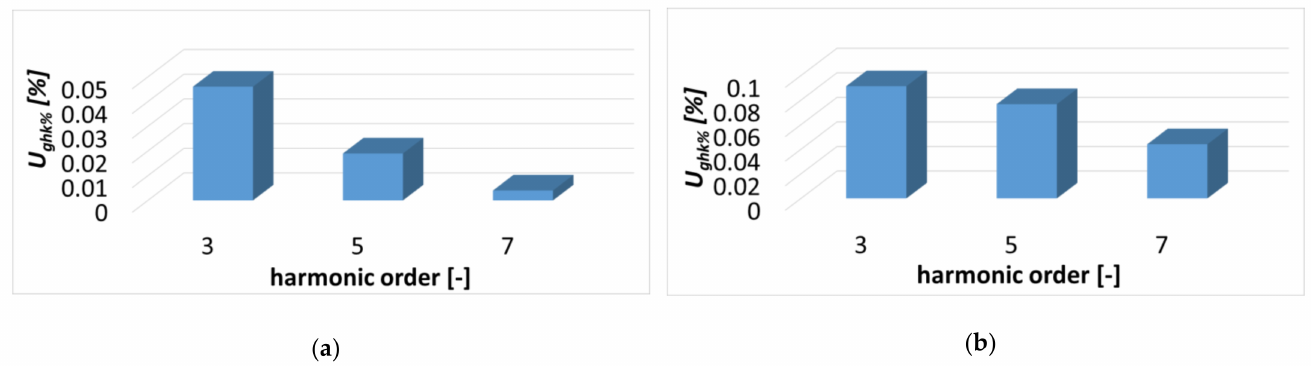
Figure 8. The percentage values of the self-generated higher harmonics ( a ) (15/ The values of the self-generated higher harmonics to the secondary voltage are cal- culated as a percentage of the RMS value of the main harmonic of the secondary